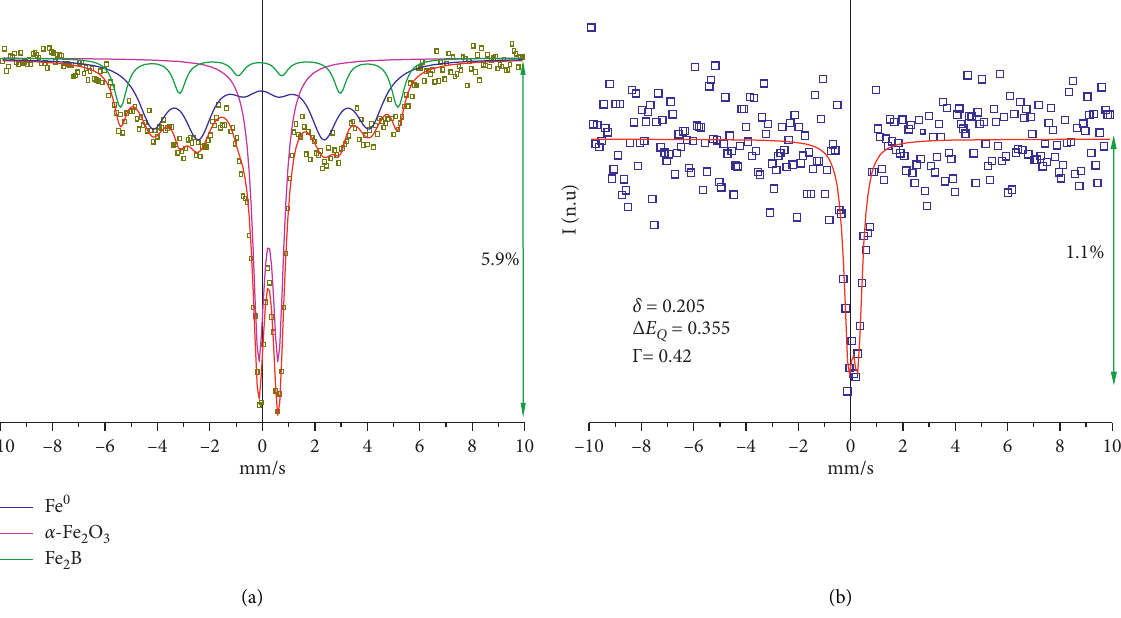
Figure 4: Mossbauer spectra of (a) FeNPs and (b) Chi-EGDE-Fe.